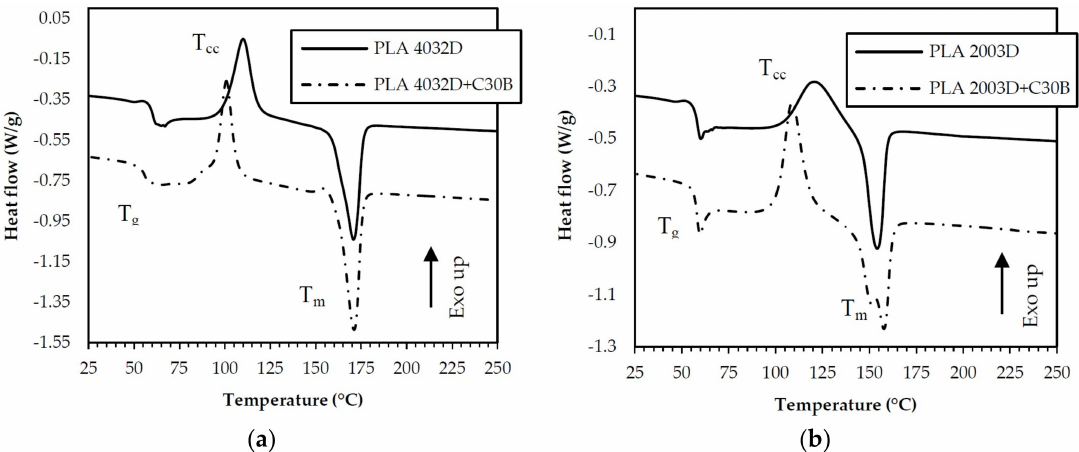
Figure 5. First heating of the filaments of PLA 4032D and PLA 4032D+C30B ( a ) and PLA 2003D and PLA 2003D+C30B ( b